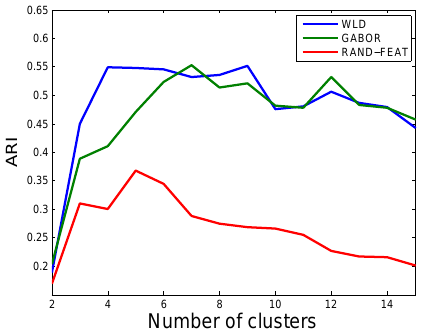
Figure 5: Adjusted Rand Index for three feature descriptors (e.g., WLD, Gabor, Rand